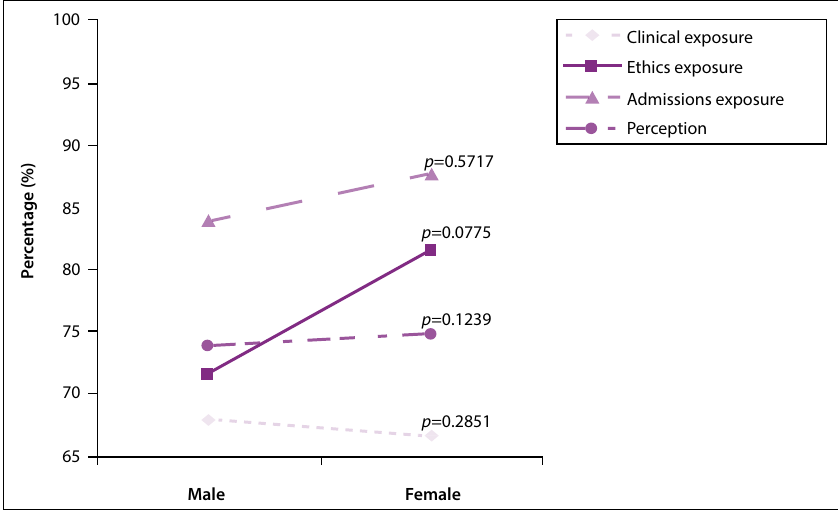
Fig. 4. Experience and perception of the rotation, ranked according to mean score.